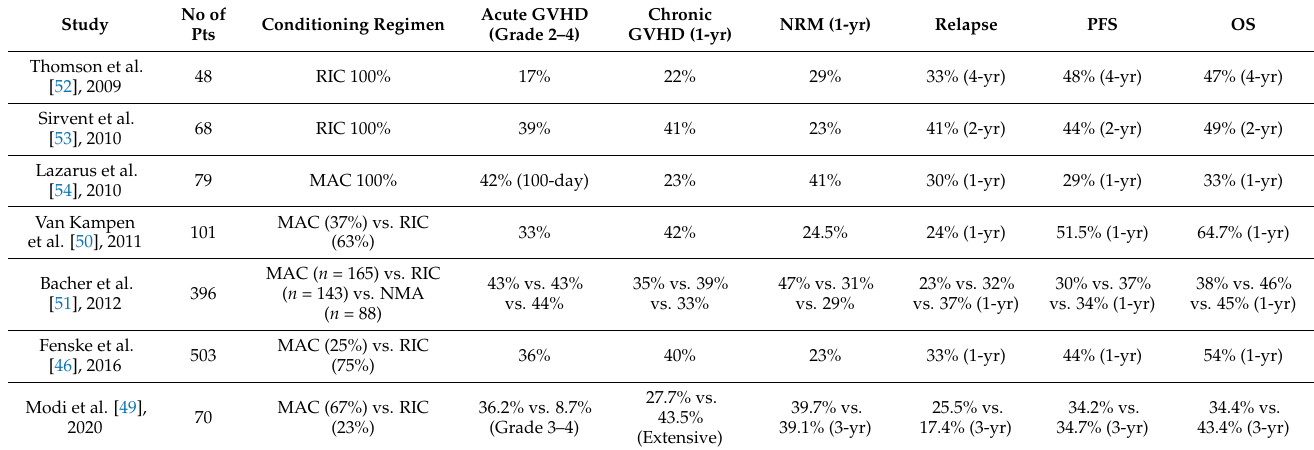
Table 1. Outcomes of allogeneic stem cell transplants in